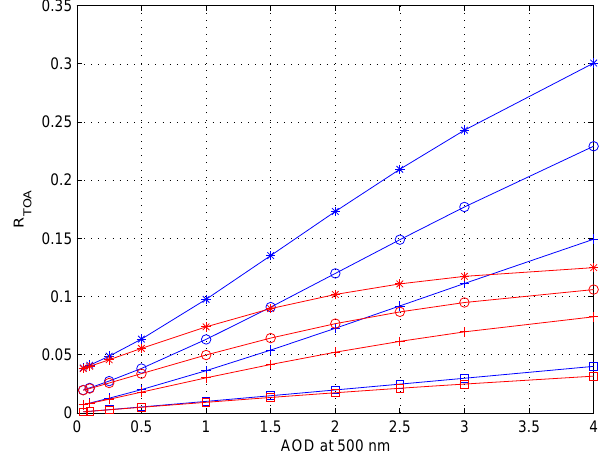
Figure 1. Calculated TOA reflectances for the weakly (blue) and strongly (red) absorbing fine-mode aerosol components as function of the reference AOD at 0.500µm and for the four AATSR wave- lengths: star 0.555µm, circle 0.659µm, plus 0.865µm, and square 1.610µm. In this example the geometry is set to a solar zenith an- gle of 30 ◦ , a satellite viewing zenith angle of 5 ◦ (near nadir), and a relative azimuth angle of 10 ◦ . Table 2. Wavelength dependence of the single scattering albedo SSA for the weakly and strongly absorbing fine-mode aerosol com- ponents. The values are computed for the optical indices in Table 1. Wavelength Weakly Strongly absorbing